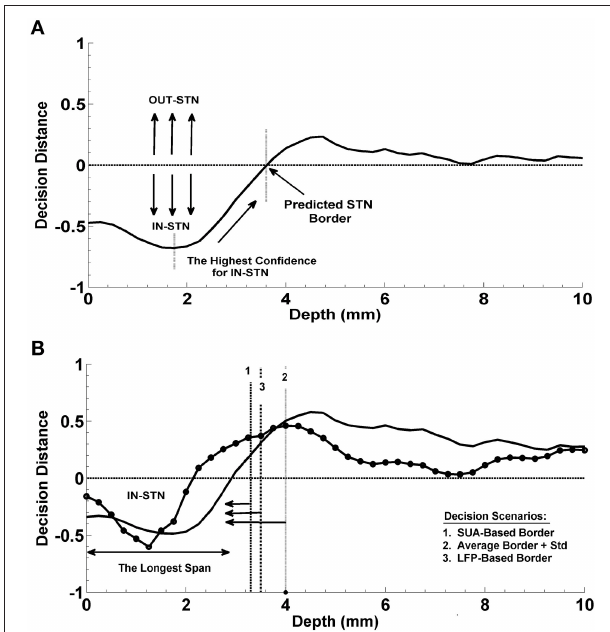
FIGURE 3 | Prediction of the dorsal border of STN and prediction of optimal track. (A) Decision strategy in the prediction of dorsal border of STN. The classifier trained by contrasting the LFP sub-band features coming from inside and outside of STN gives a decision at each depth from top to bottom. These decision distances were used as a measure of confidence. Depth with the highest confidence for IN-STN decisions was marked. Then decisions were traced back where the LDA classifier voted for OUT-STN. This point where the classifier made IN vs. OUT decision transition was chosen as the predicted dorsal border of STN. (B) Decision strategy in the optimal track prediction. Classifier trained by contrasting the LFP subband features of selected track vs. un-selected tracks below the dorsal border of STN returned decision distances at all depths. The decision distances were used in three different scenarios: (1) Below the SUA-based STN border, (2) below the one standard deviation from the average of STN border, and (3) below the LFP-based STN border obtained from prediction of dorsal border of STN. The decision distance with the longest span was used as a decision criterion to predict the optimal